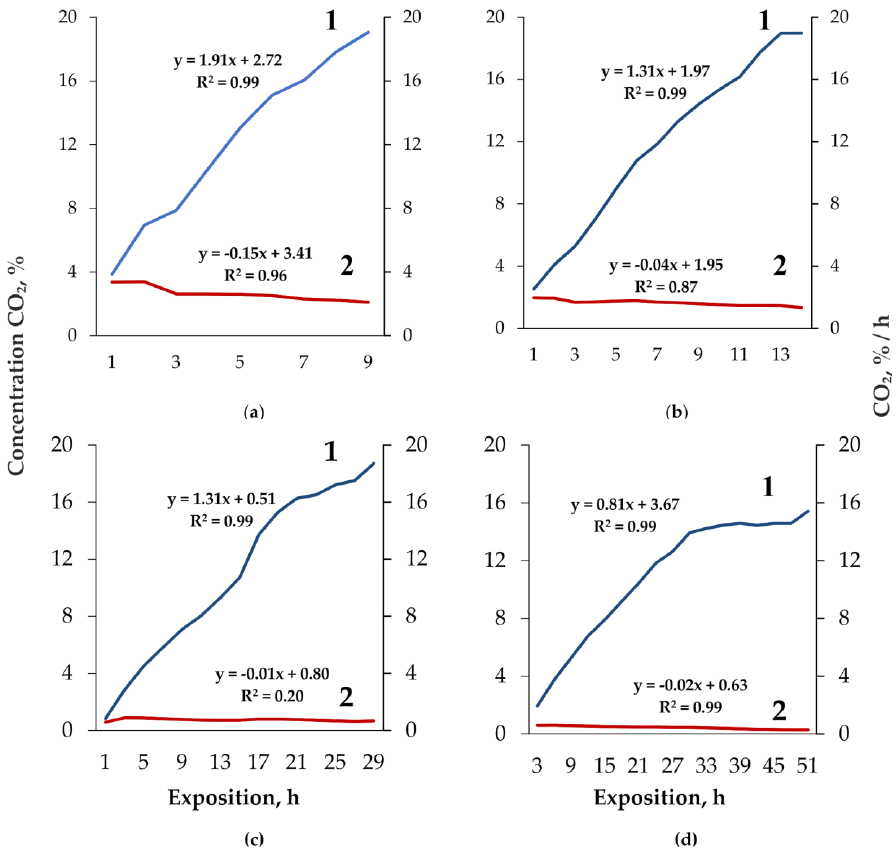
Figure 4. CO 2 concentration (1) and intensity of its emission (2) by Fomes fomentarius ( a ), Fomitopsis pinicola ( b ) basidiocarps and Fomes fomentarius ( c ), Fomitopsis betulina ( d ) substrates. R 2 —coefficient of